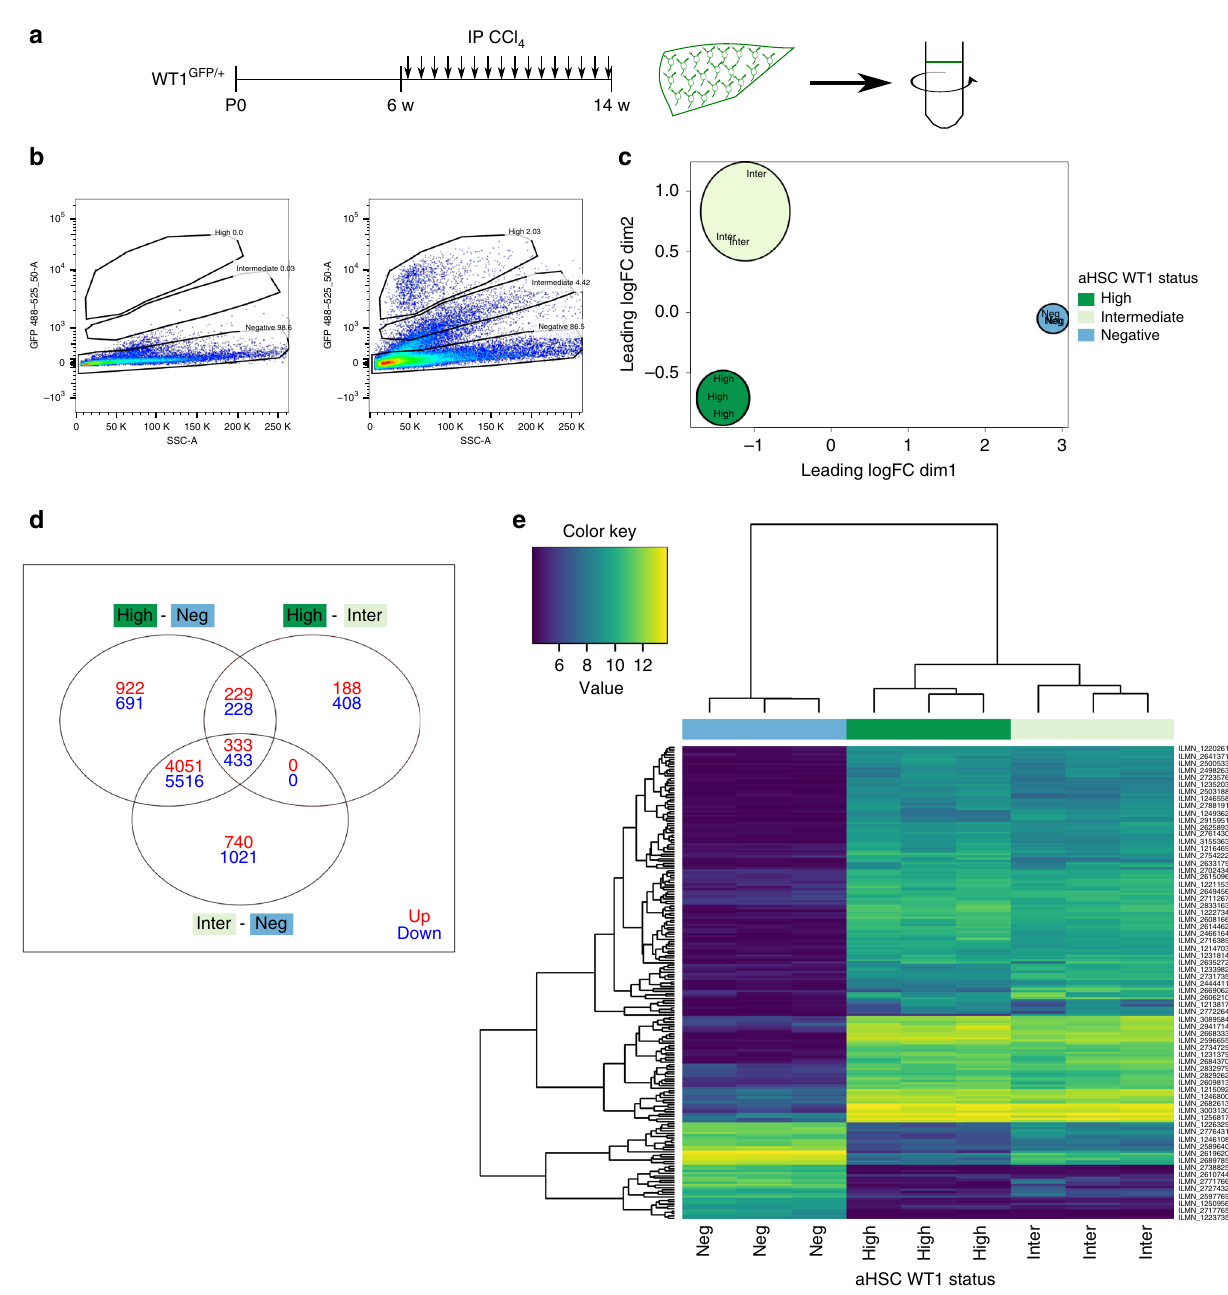
Fig. 5 Subpopulations of aHSCs de fi ned by WT1 expression in chronic fi brotic injury in vivo are transcriptionally distinct. a WT1 GFP/ + animals were iteratively injured with CCl 4 to induce HSC activation and fi brosis prior to isolation of subpopulations de fi ned by WT1(GFP) expression by fl ow cytometry ( n = 3 animals). b Subpopulations of WT1(GFP)-high and WT1(GFP)-intermediate were present within the isolated HSC fraction from injured WT1 GFP/ + animals (right panel) but not injured wild-type animals (left, representative plots with population percentages). c A multi-dimensional scaling plot of gene expression after microarray analysis of WT1-positive in vivo activated and WT1-negative in vitro aHSCs demonstrated separation based on WT1(GFP) expression. d Over and underexpressed probes between subpopulations of aHSCs determined by fi tting of a linear model. e Hierarchical clustering independently separated subpopulations into groups de fi ned by WT1